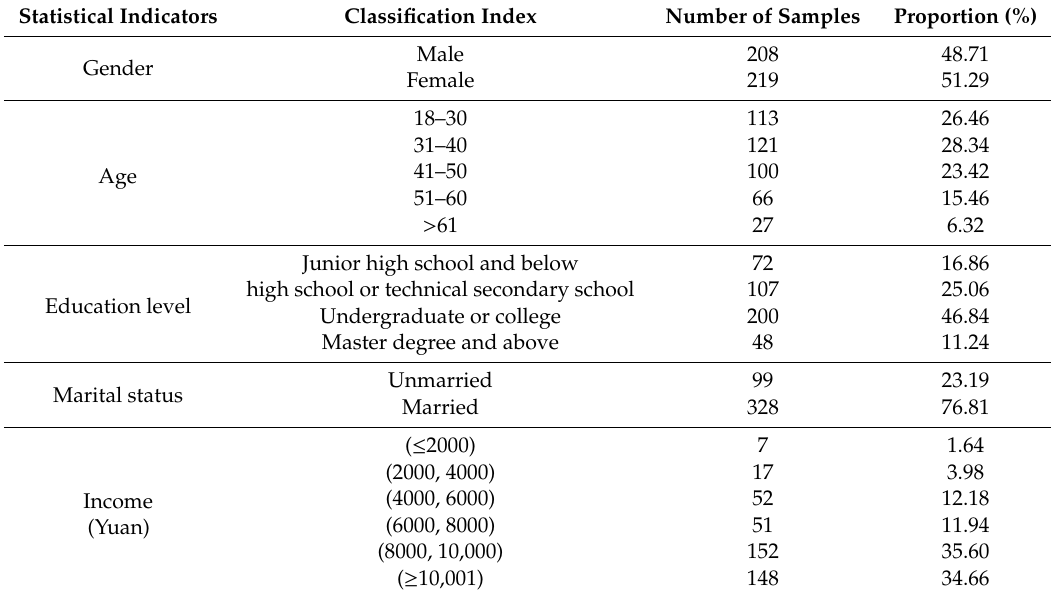
Table 2. Personal characteristics of the